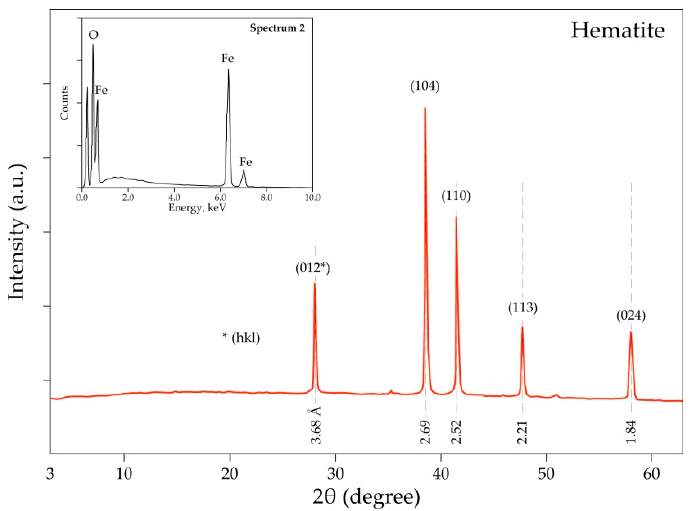
Figure 5. XRD diffractogram and embedded SEM-EDS spectrum (top-left corner) of the hematite sample.